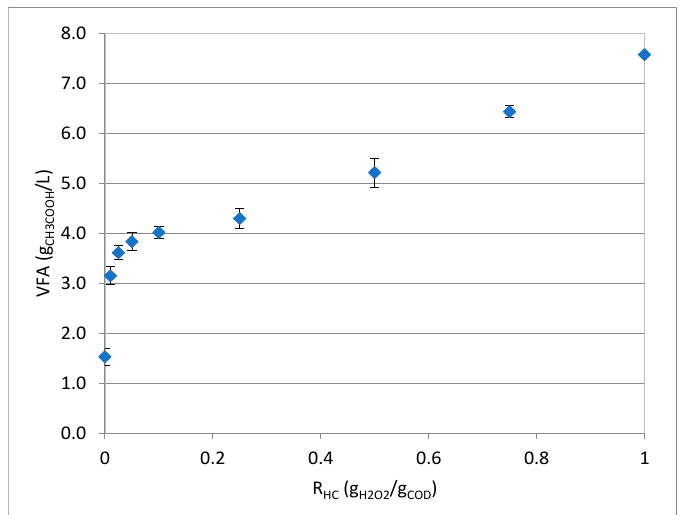
Figure 1. COD abatements detected in the AHP tests conducted with different H 2 O 2 dosages.